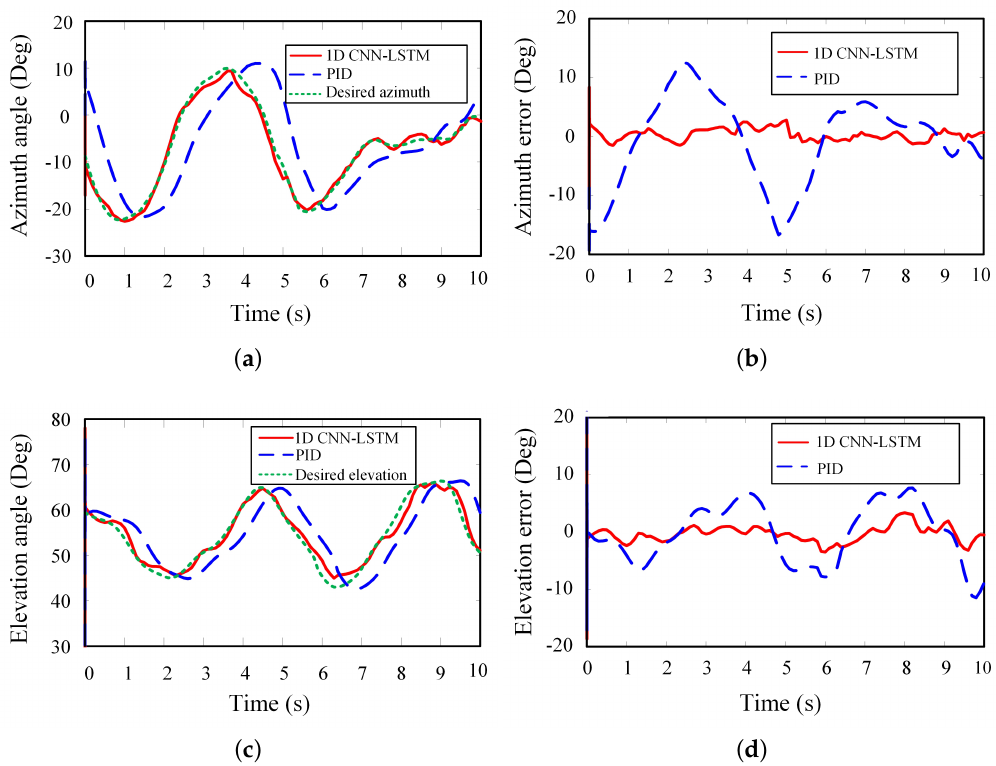
Figure 9. Comparison of the predict results and actual results in the field application. ( a ) Azimuth angle. ( b ) Error of azimuth angle. ( c ) Elevation angle. ( d ) Error of elevation